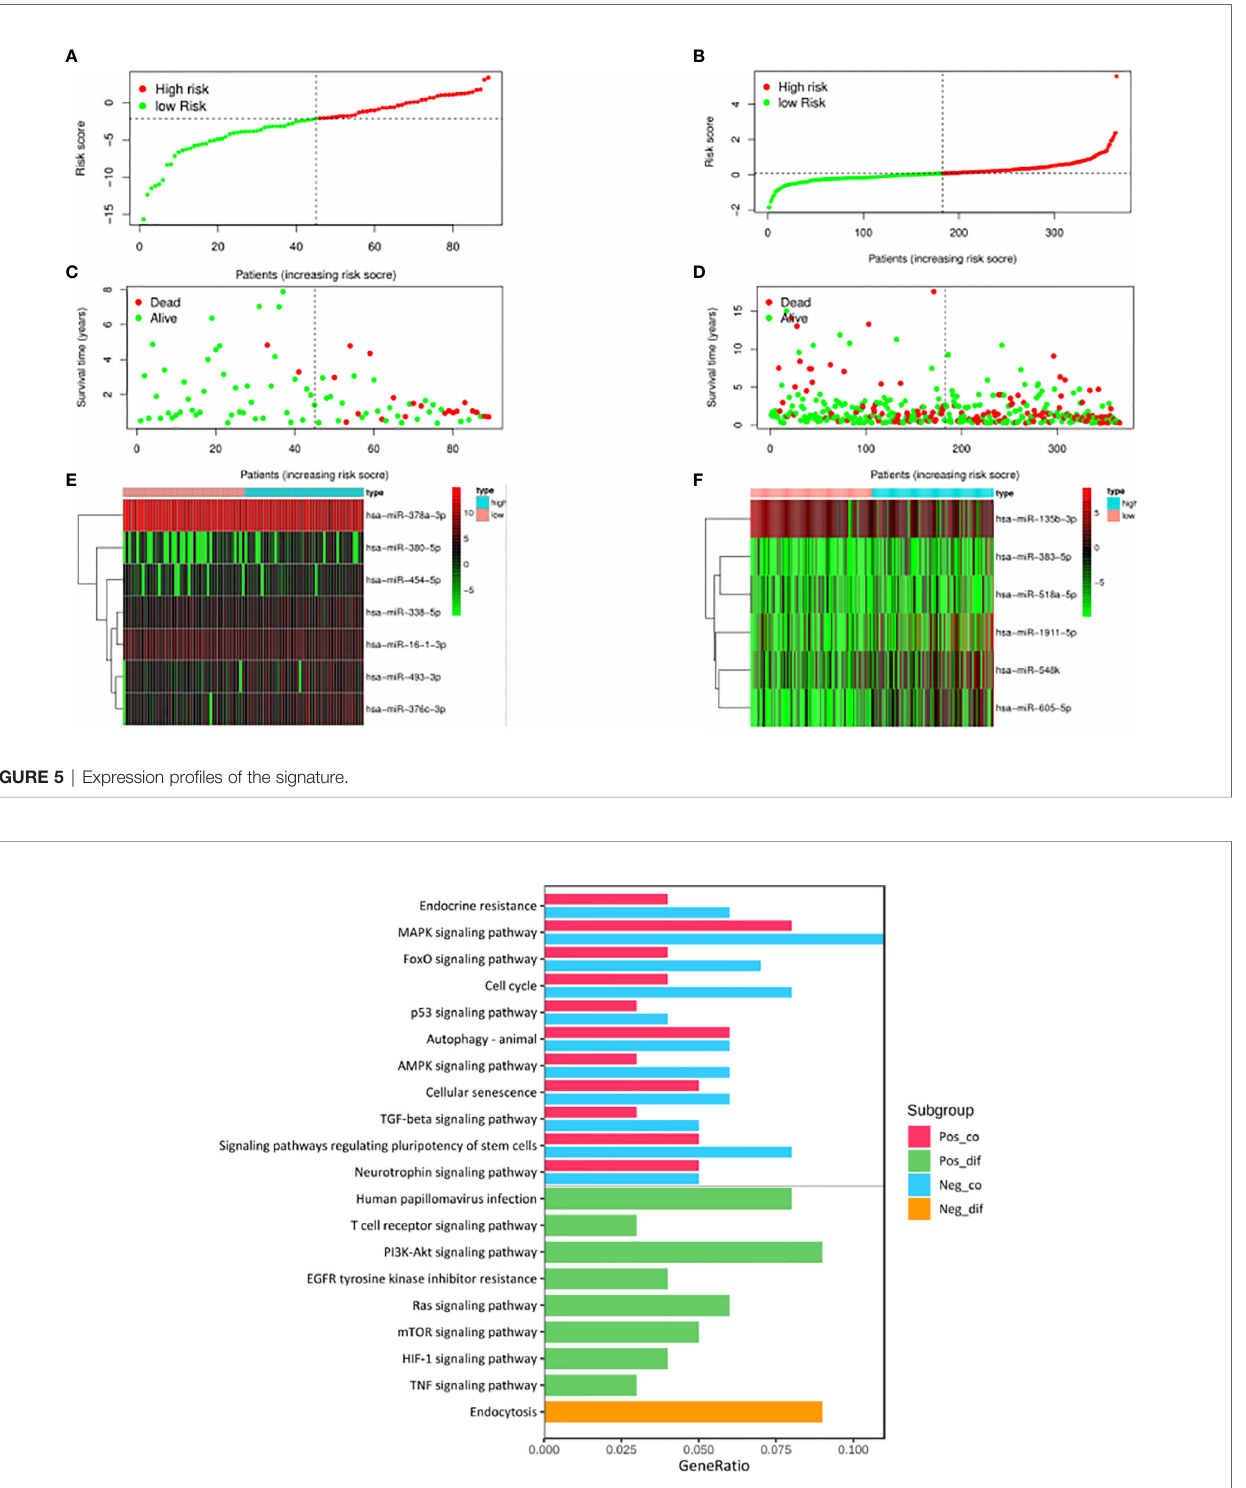
FIGURE 6 | KEGG Pathway Enrichment Analysis. The pathways at the upper area divided by a grey line were the common ones between HPV+ and HPV- groups while those at the lower area were the distinct ones. Pos_co colored red stood for the enrichment outcomes of common pathways in HPV+ group and Neg_co colored blue stood for those in HPV- group. Pos_dif colored green were the enrichment outcomes of different pathways in HPV+ group and Neg_dif colored green were those in HPV-